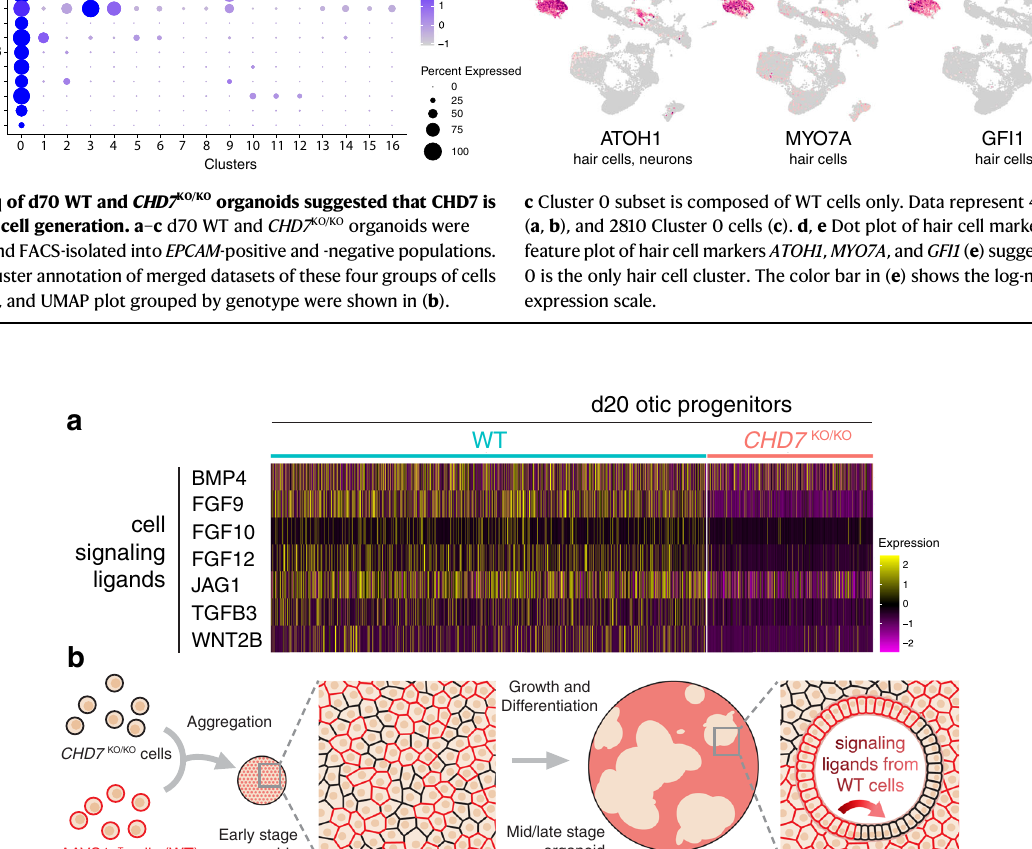
progenitors. b WT- CHD7 KO/KO chimeric organoid culture strategy for supplying CHD7 KO/KO mutant cells with diffusible morphogens and cell surface signaling ligands from neighboring and nearby AAVS1 mT -labeled WT